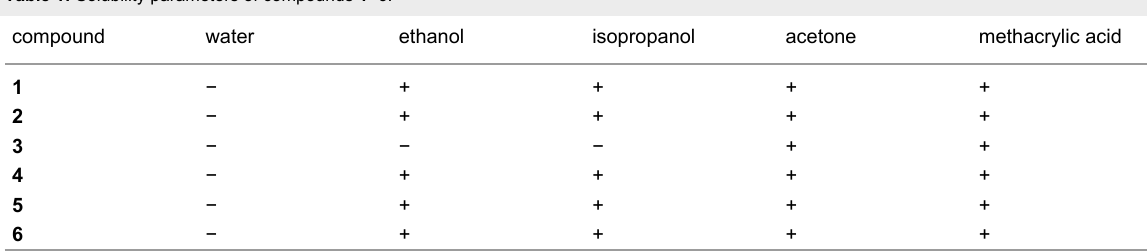
Table 1: Solubility parameters of compounds 1–6 . a compound water ethanol